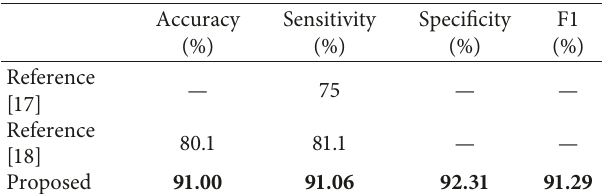
Table 2: Comparison with other methods of depression classifi- cation based on eye movement signals.